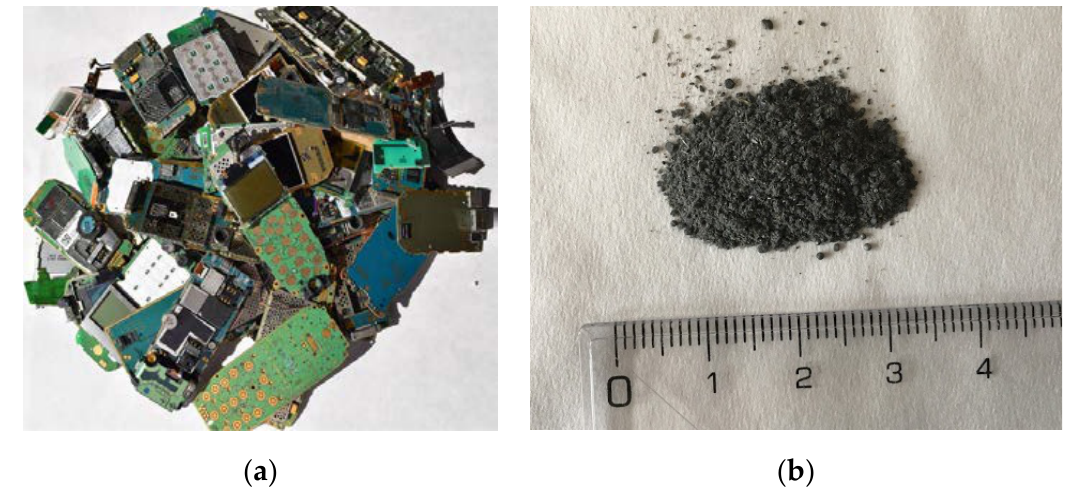
Figure 1. ( a ) Printed circuit boards (PCBs) of mobile phones; ( b ) analytical sample of PCBs (photos taken by author).